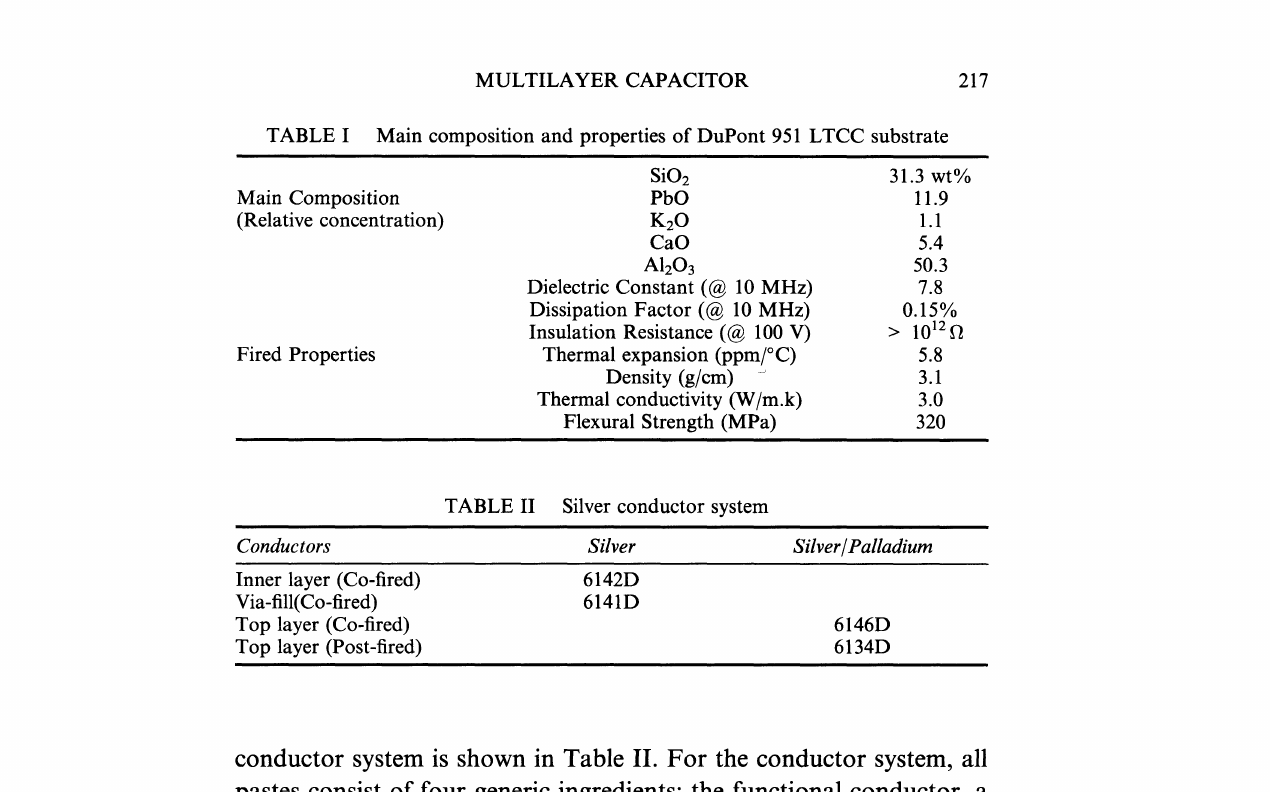
Silver conductor system Silver